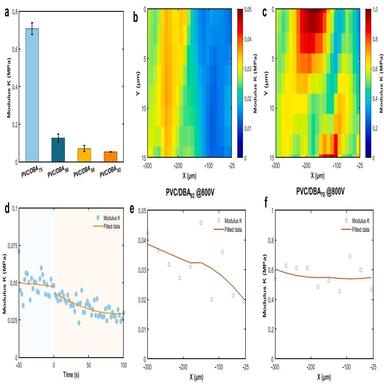
Modulus change within PVC gel during electrical stimulation. Relationship between modulus and plasticizer content of PVC gels (a). Comparison of modulus distribution after electrical stimulation for PVC/DBA92 gel (b) and PVC/DBA75 gel (c). The change of PVC/DBA92 gel's modulus with increasing electrical stimulation time at 800 V (d). Comparison of the plasticizer content distribution along the X-axis at line Y = 10 for PVC/DBA92 gel (e) and PVC/DBA75 gel (f).